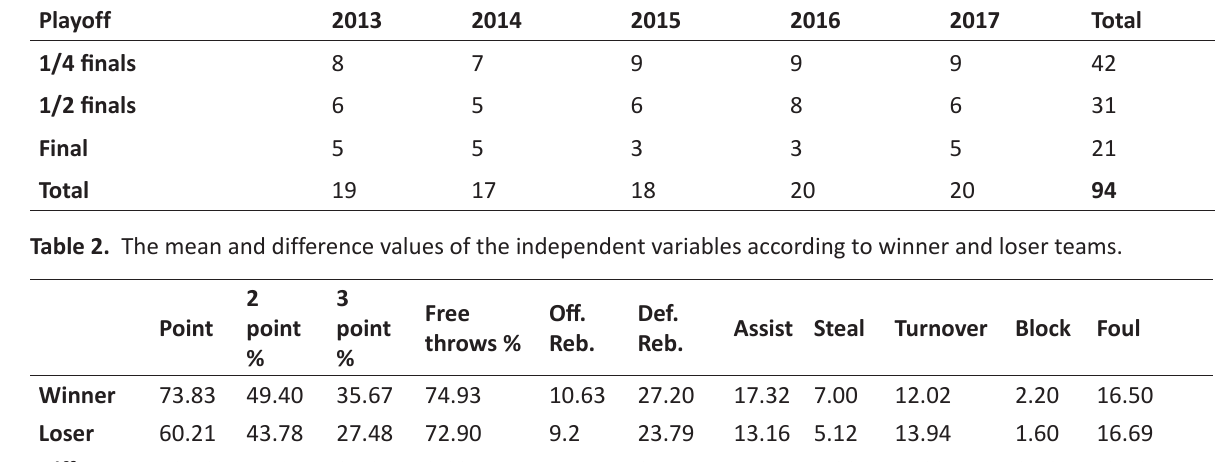
Table 1. Playoff games played between the years of 2013-2017.